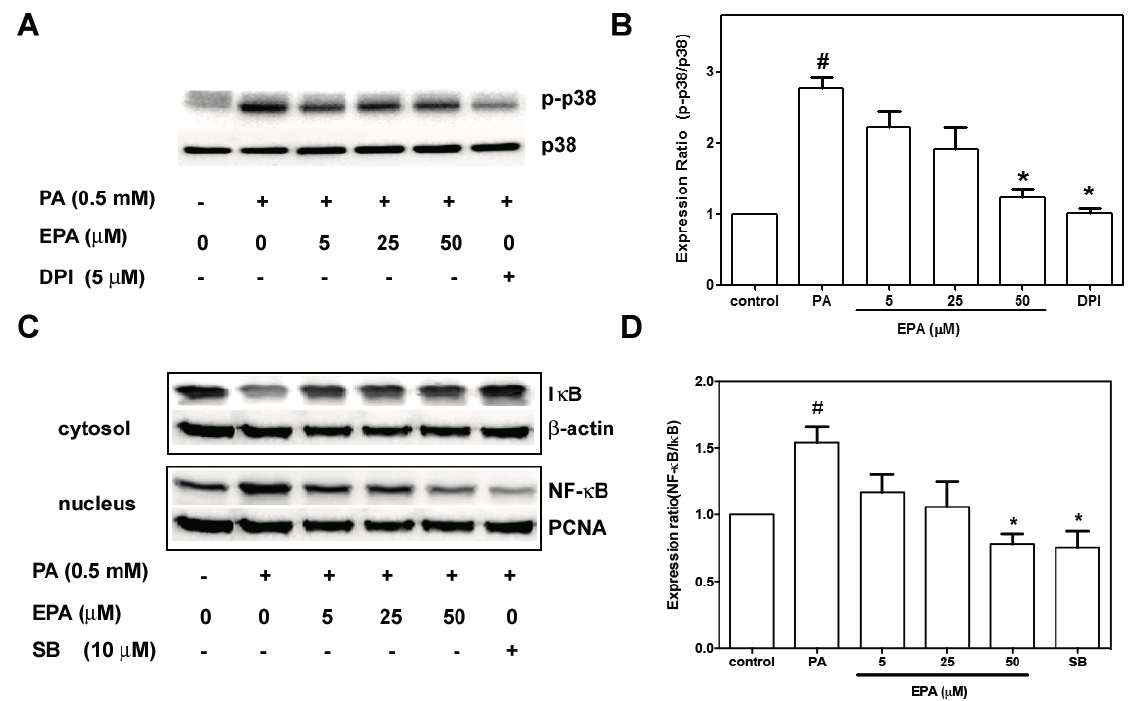
7. Effects of EPA on PA-induced p38 MAPK and NF- ĸ B activation. ( A ) The HUVECs were pre-treated with EPA for 2 h or with the NADPH oxidase inhibitor DPI for 30 m and subsequently treated with 0.5 mM PA for 18 h. Phospho-p38 MAPK and p38 MAPK expression were subjected to western blot analyses; ( B ) The quantifications of the related phospho-p38 MAPK and total p38 MAPK are shown; ( C ) The HUVECs were pretreated with EPA for 2 h or with the p38 MAPK inhibitor SB 203580 for 30 m and subsequently treated with 0.5 mM PA for 18 h. Cytosolic I κ B and nuclear NF- κ B were determined by immunoblotting; ( D ) The quantifications of the relevant cytosolic I κ B and nuclear NF- κ B are shown. The values are presented as the means ± the S.E.s of three independent experiments. # p < 0.05 vs. untreated control; * p < 0.05 vs. PA